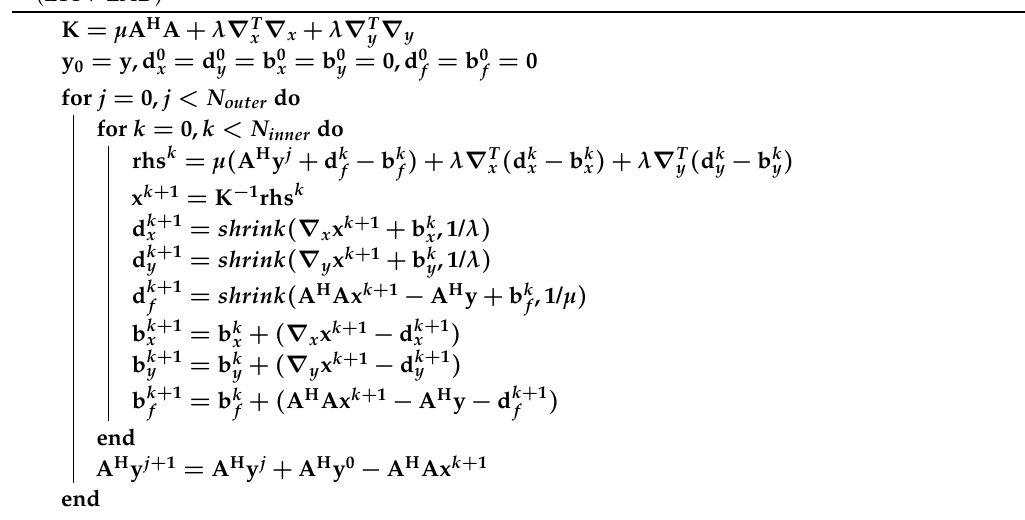
Algorithm 2: The pseudocode for the (cid:96) 1 total variation-regularized least absolute deviation